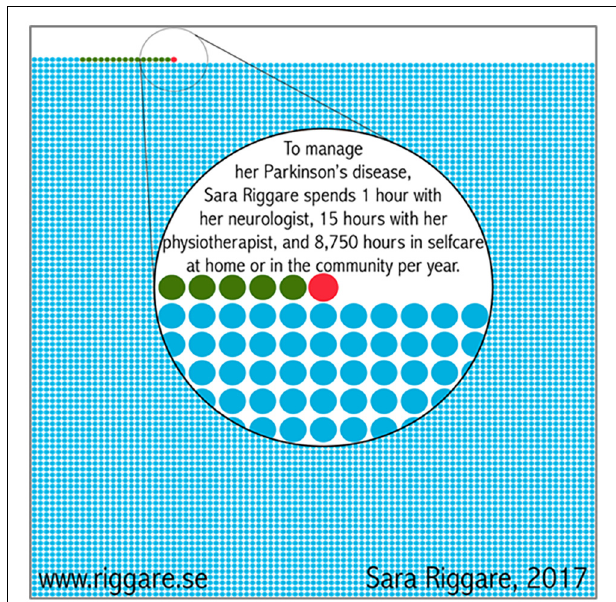
FIGURE 1 | Patients’ perspective on common care from